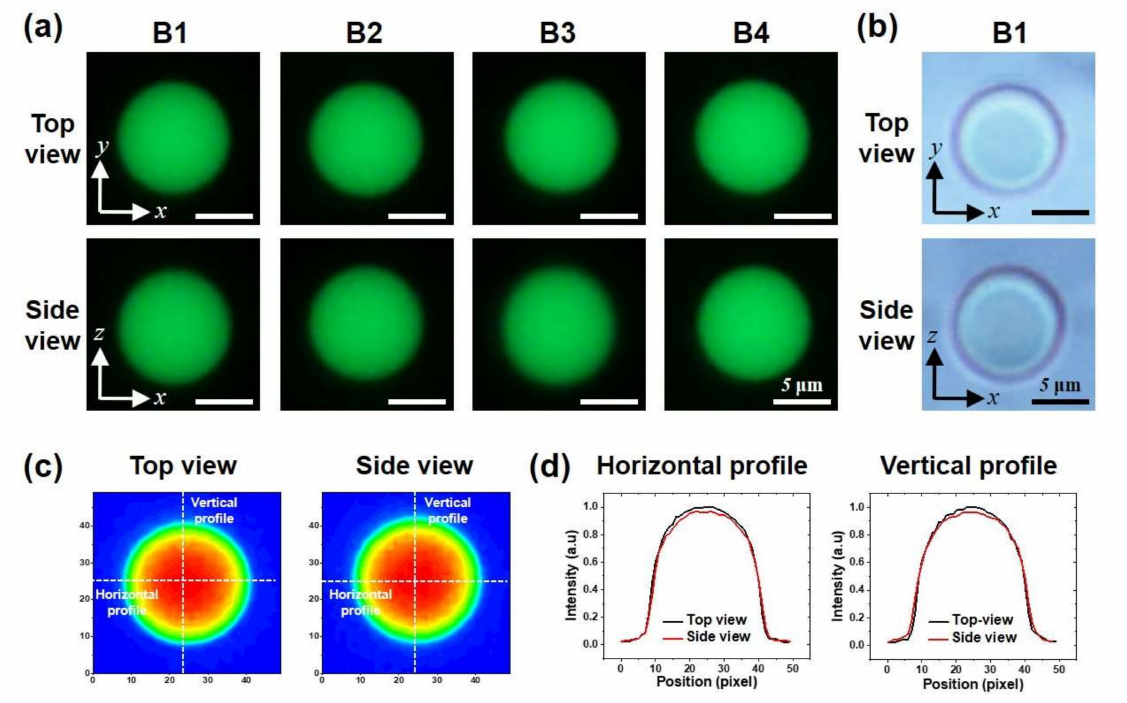
Figure 4. Evaluation of bidirectional imaging with fluorescent beads. ( a ) Fluorescent microscopy images of four beads from top-view and side-view. ( b ) Bright-field images of bead 1. ( c ) Fluorescent intensity contours of bead 1 and ( d ) its intensity profile through the center lines in horizontal and vertical